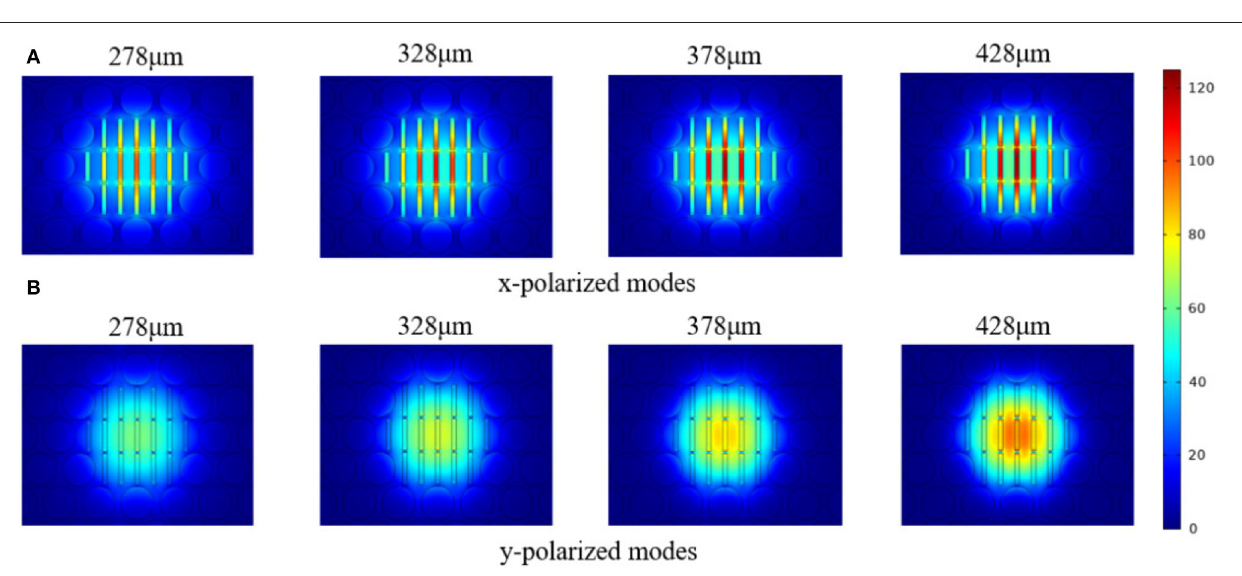
FIGURE 2 | The mode field distribution of the proposed THz-PCF for (A) x-polarized modes and (B) y-polarized modes for different D core at the frequency of 1.5 THz when P =